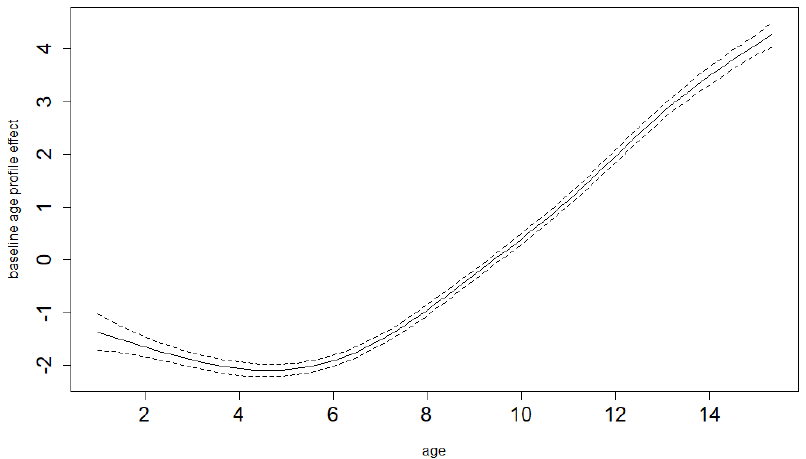
Figure 4. Baseline BMI age profile for girls, estimated smooth trend (solid line) and pointwise 95% confidence interval limits (dotted lines). Age in years.